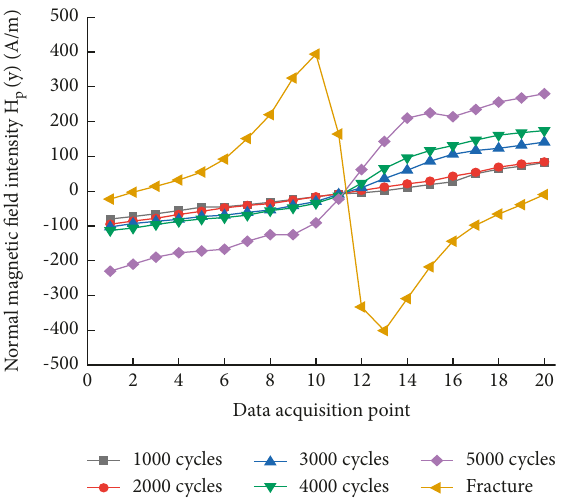
Figure 5: H p ( y ) curves corresponding to each fatigue damage stage.